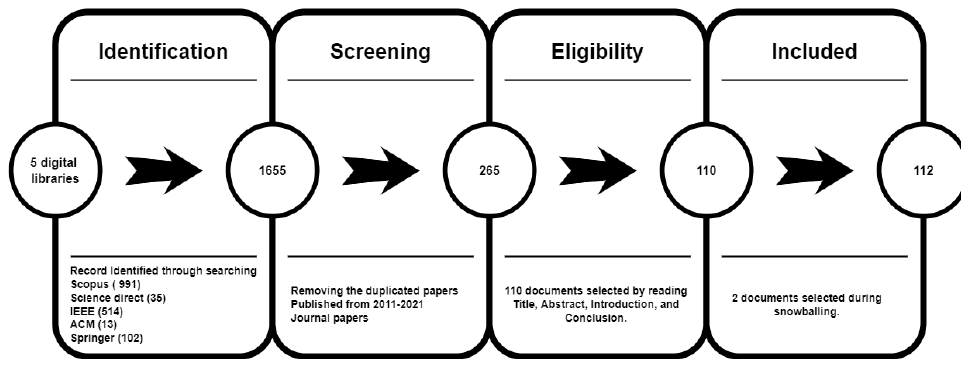
Figure 6. PRISMA flowchart for relevant paper selection.